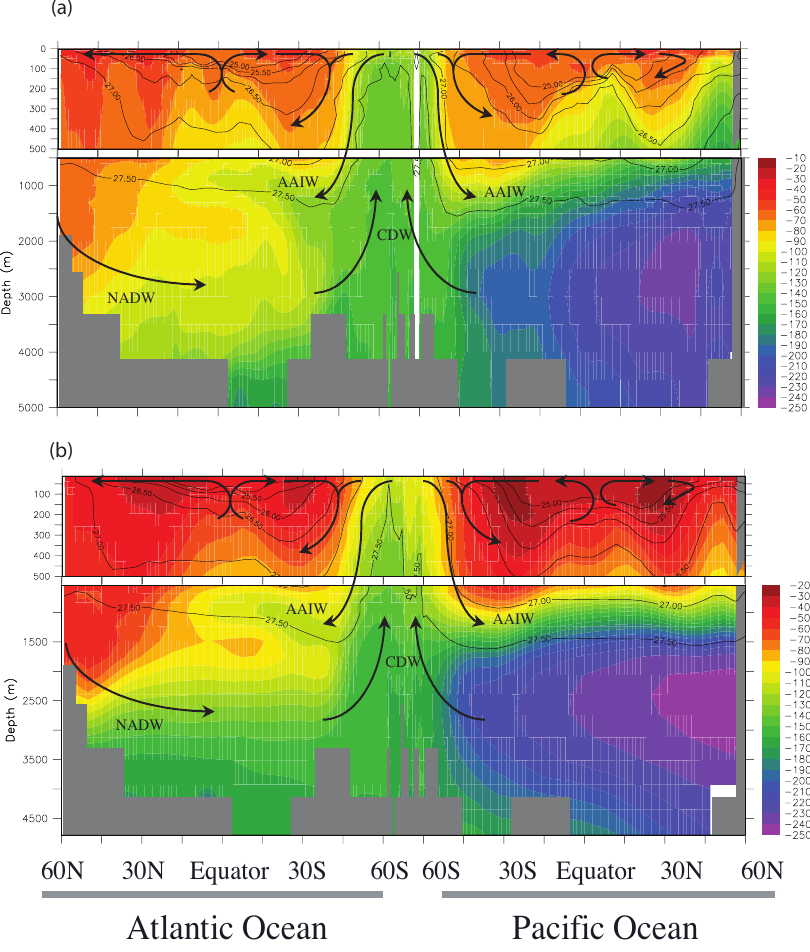
Fig. 4. Southern Ocean-centric view of pre-bomb 1 14 C in the ocean interior (per mil). (a) GLODAP (Key et al., 2004). (b) MOM3 P2A (Gnanadesikan et al.,